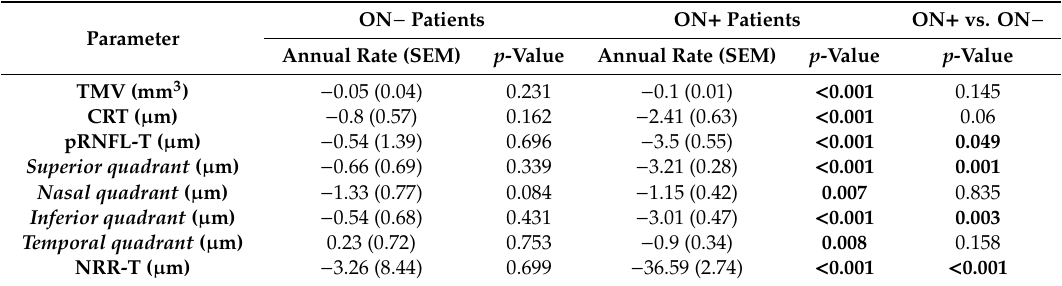
Table 4. Annual change rates of the OCT parameters in optic neuritis (ON) − and ON + patients. ON − Patients ON + Patients ON + vs. ON − Parameter Annual Rate (SEM) p -Value Annual Rate (SEM) p -Value p -Value TMV (mm 3 ) − 0.05 (0.04) 0.231 − 0.1 (0.01) < 0.001 0.145 CRT ( µ m) − 0.8 (0.57) 0.162 − 2.41 (0.63) < 0.001 0.06 pRNFL-T ( µ m) − 0.54 (1.39) 0.696 − 3.5 (0.55) < 0.001 0.049 Superior quadrant ( µ m) − 0.66 (0.69) 0.339 − 3.21 (0.28) < 0.001 0.001 Nasal quadrant ( µ m) − 1.33 (0.77) 0.084 − 1.15 (0.42) 0.007 0.835 Inferior quadrant ( µ m) − 0.54 (0.68) 0.431 − 3.01 (0.47) < 0.001 0.003 Temporal quadrant ( µ m) 0.23 (0.72) 0.753 − 0.9 (0.34) 0.008 0.158 NRR-T ( µ m) − 3.26 (8.44) 0.699 − 36.59 (2.74) < 0.001 <